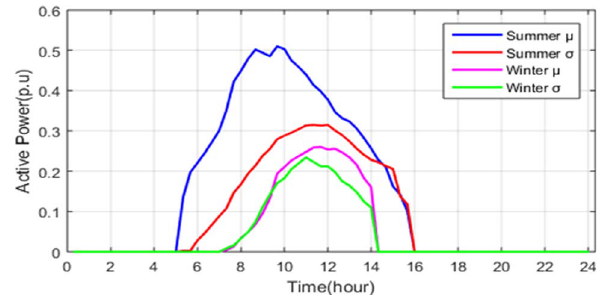
Figure 25. Comparison of THD of proposed and existing approaches in summer and